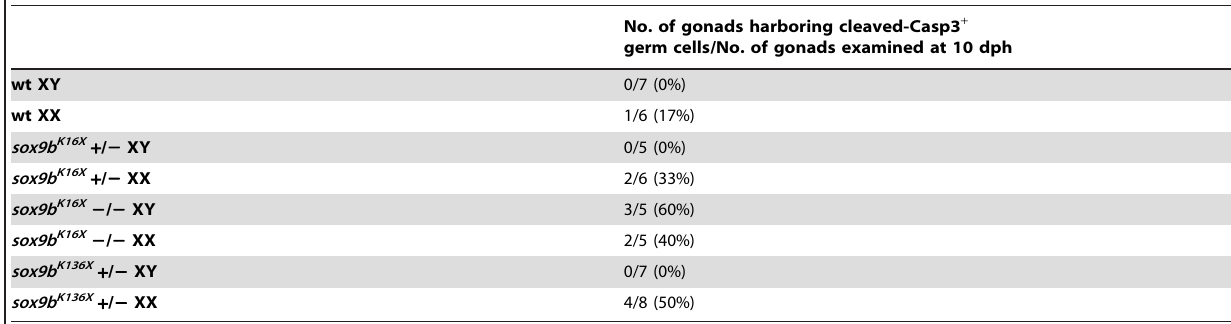
Table 2. Increased apoptotic activity in the germ cells of sox9b mutant